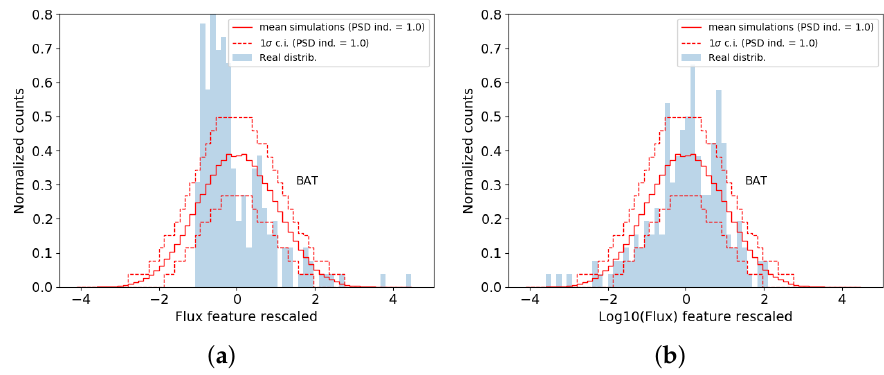
Figure 2. Similar to Figure 1 for BAT lightcurves. Both ( a ) normal simulations and ( b ) lognormal ones are not great fits with SW p -values of 8.29 × 10 − 16 (i.e., p (cid:28) 0.001) and 1.30 × 10 − 6 (also, p (cid:28) 0.001), even though the latter appears to be better. This mismatch is potentially due to the multi-modal, bursty structure.